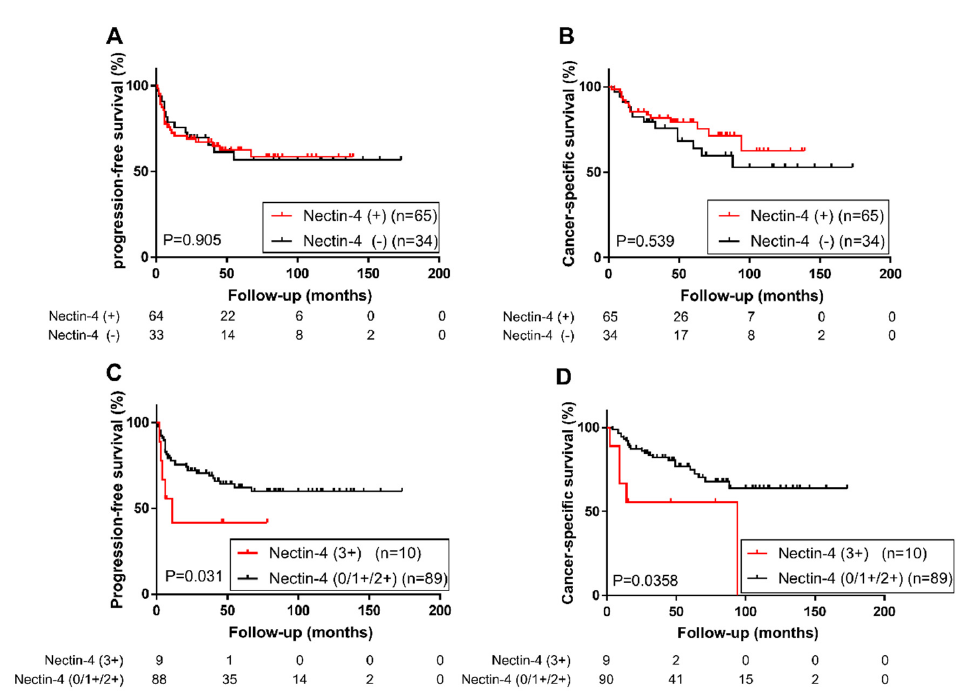
Supplementary Figure S1A,B. Int. J. Mol. Sci. 2020 , 21 , x FOR PEER REVIEW